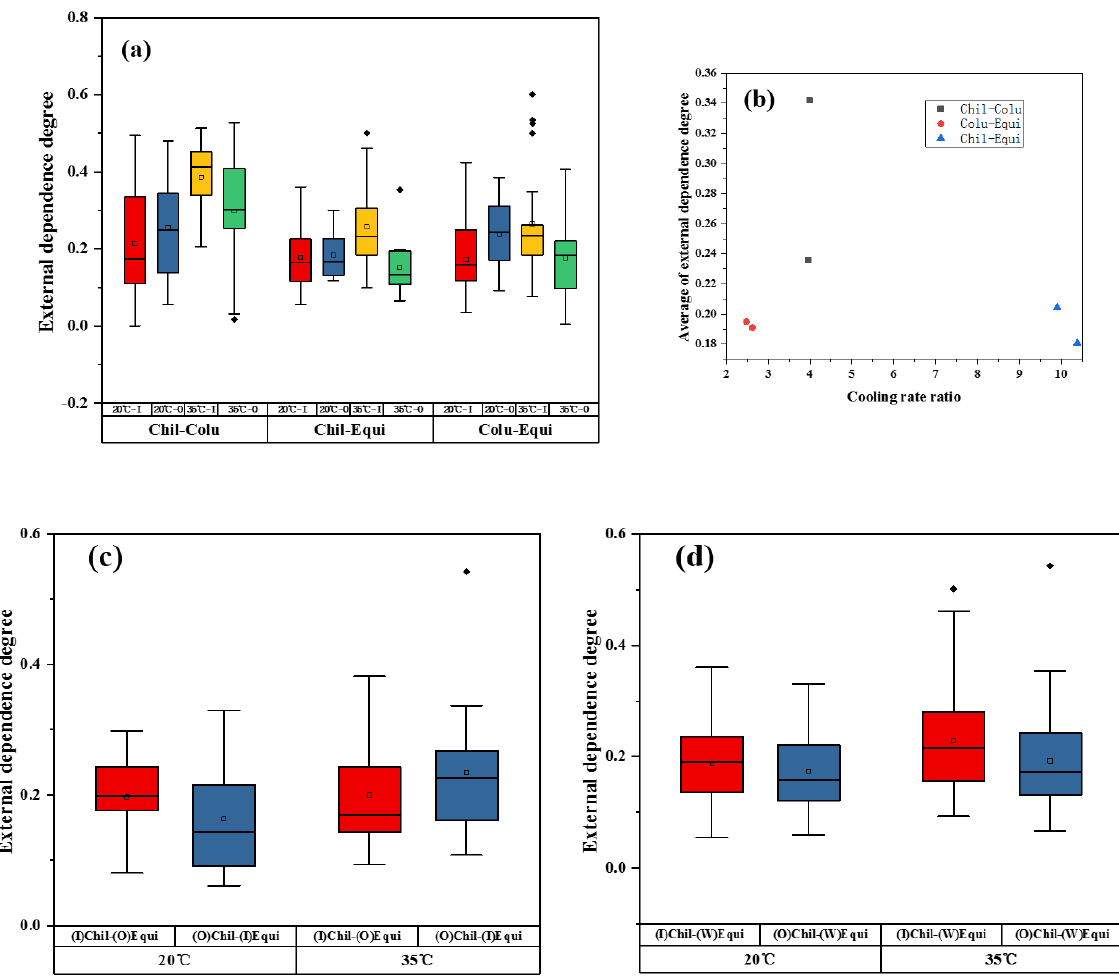
Figure 6. External dependence degrees between different zones in CC billets. Chil-Colu means the correlation between the chilled zone and the columnar grain zone. Chil-Equi means the correlation between the chilled zone and the equiaxed grain zone. Colu-Equi means the correlation between